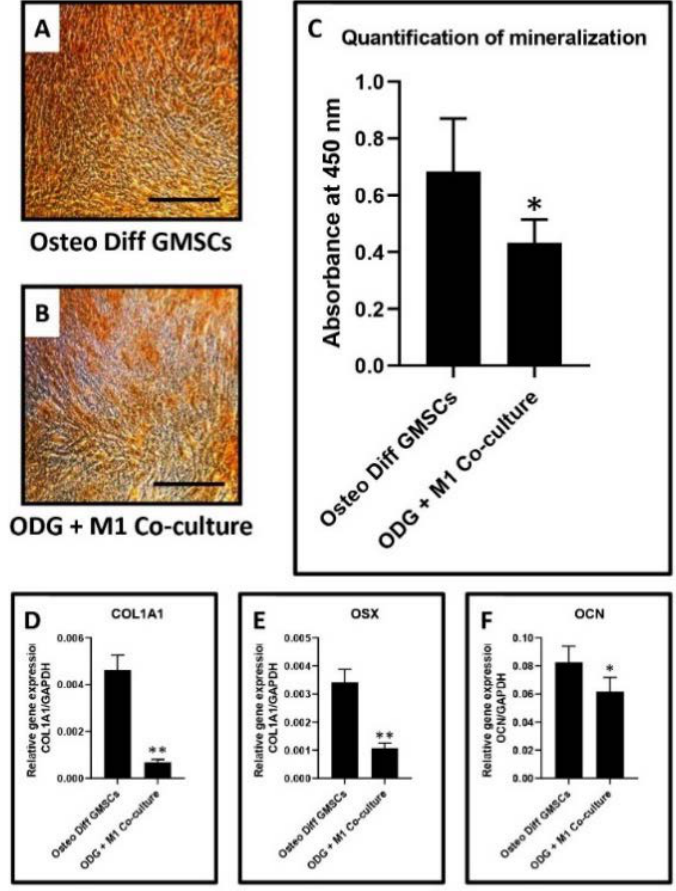
Figure 8. ( A , B )—Alizarin red S staining of osteoblasts derived from gingival stem cells versus osteoblasts derived from gingival stem cells co-cultured with macrophages. ( C )—Bar diagram depicting mineralization (* p = 0.0246) and expression of the ( D )—COL1A1 (** p < 0.0001), ( E )—OSX (** p < 0.0001), ( F )—OCN (* p = 0.0151) genes in osteoblasts derived from gingival stem cells versus osteoblasts derived from gingival stem cells co-cultured with